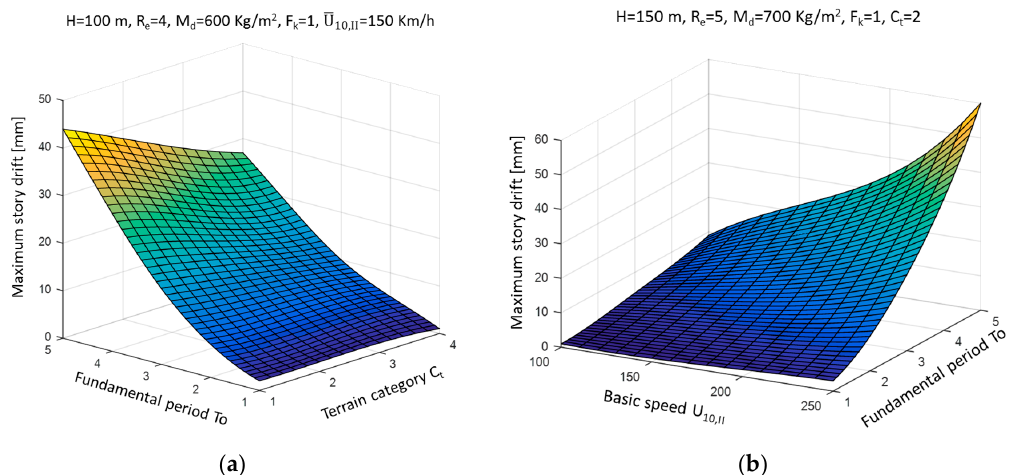
Figure 7. Maximum story drift for cases with: ( a ) H = 100 m, R e = 4, M d = 600 Kg/m 2 , F k = 1, U 10,II = 150 Km/h; ( b ) H = 150 m, R e = 5, M d = 700 Kg/m 2 , F k = 1, C t = 2.